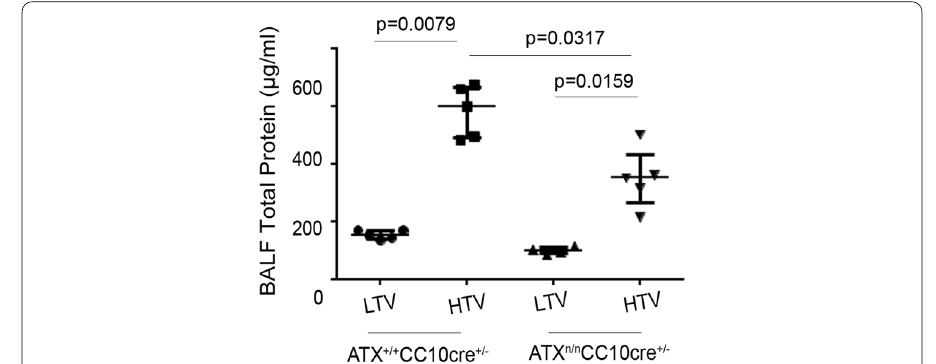
Fig. 5 Deletion of ATX from bronchial epithelial cells reduces edema and inflammation due to injurious ventilation. Total protein concentrations in BALFs of mice with (ATX + / + CC10Cre + /- ) and without (ATX